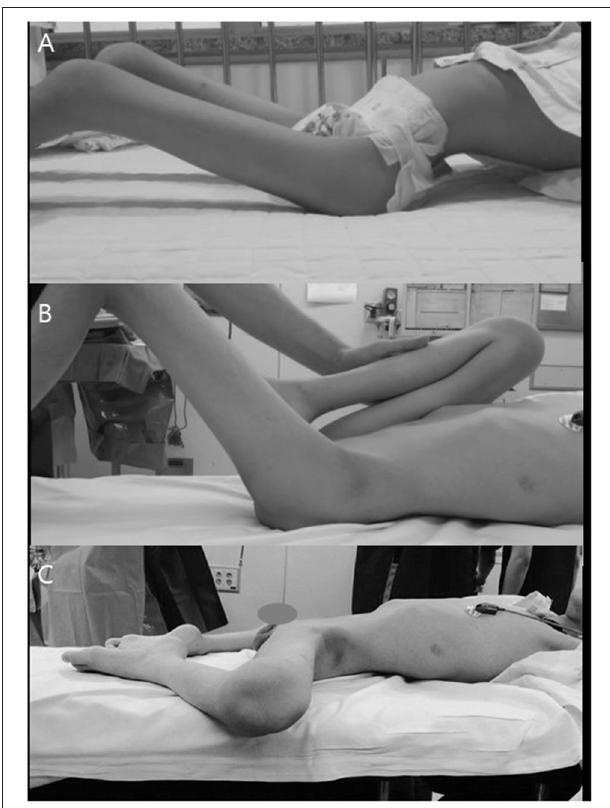
FIGURE 1 | Patient with hip flexion–abduction–external rotation contracture. (A) Compensatory increased LL due to their hip contracture. (B) Thomas test to examine the degrees of real hip flexion contracture. (C) Frog leg attitude when lying to improve comfort and reduce the increased